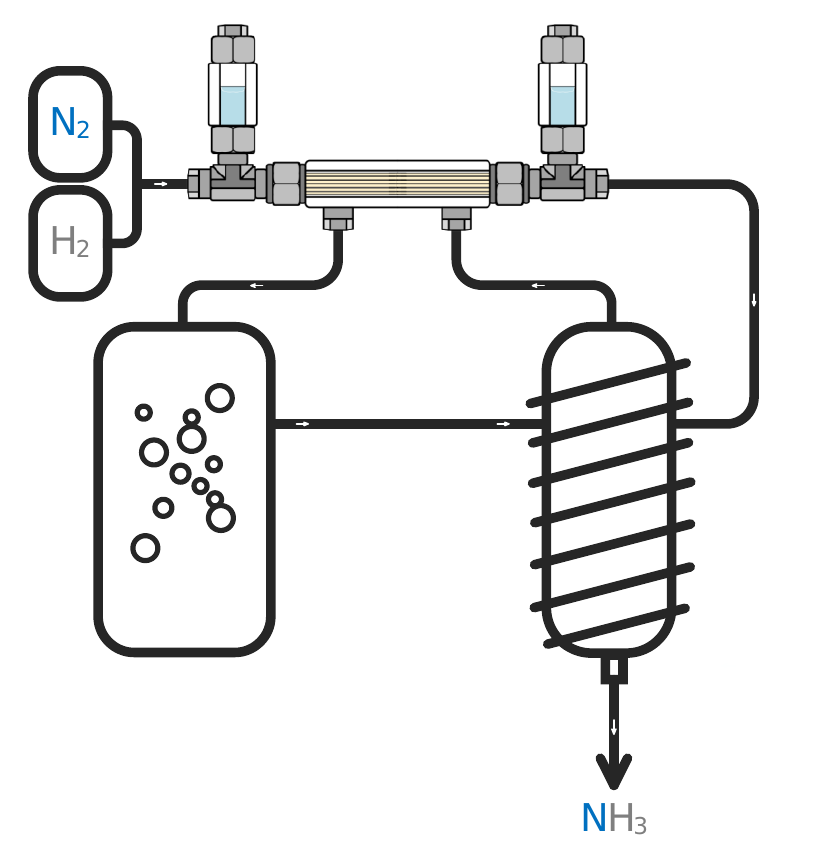
Figure 2. The principal scheme of the Haber – Bosch process with built-in membrane-assisted gas absorption unit.